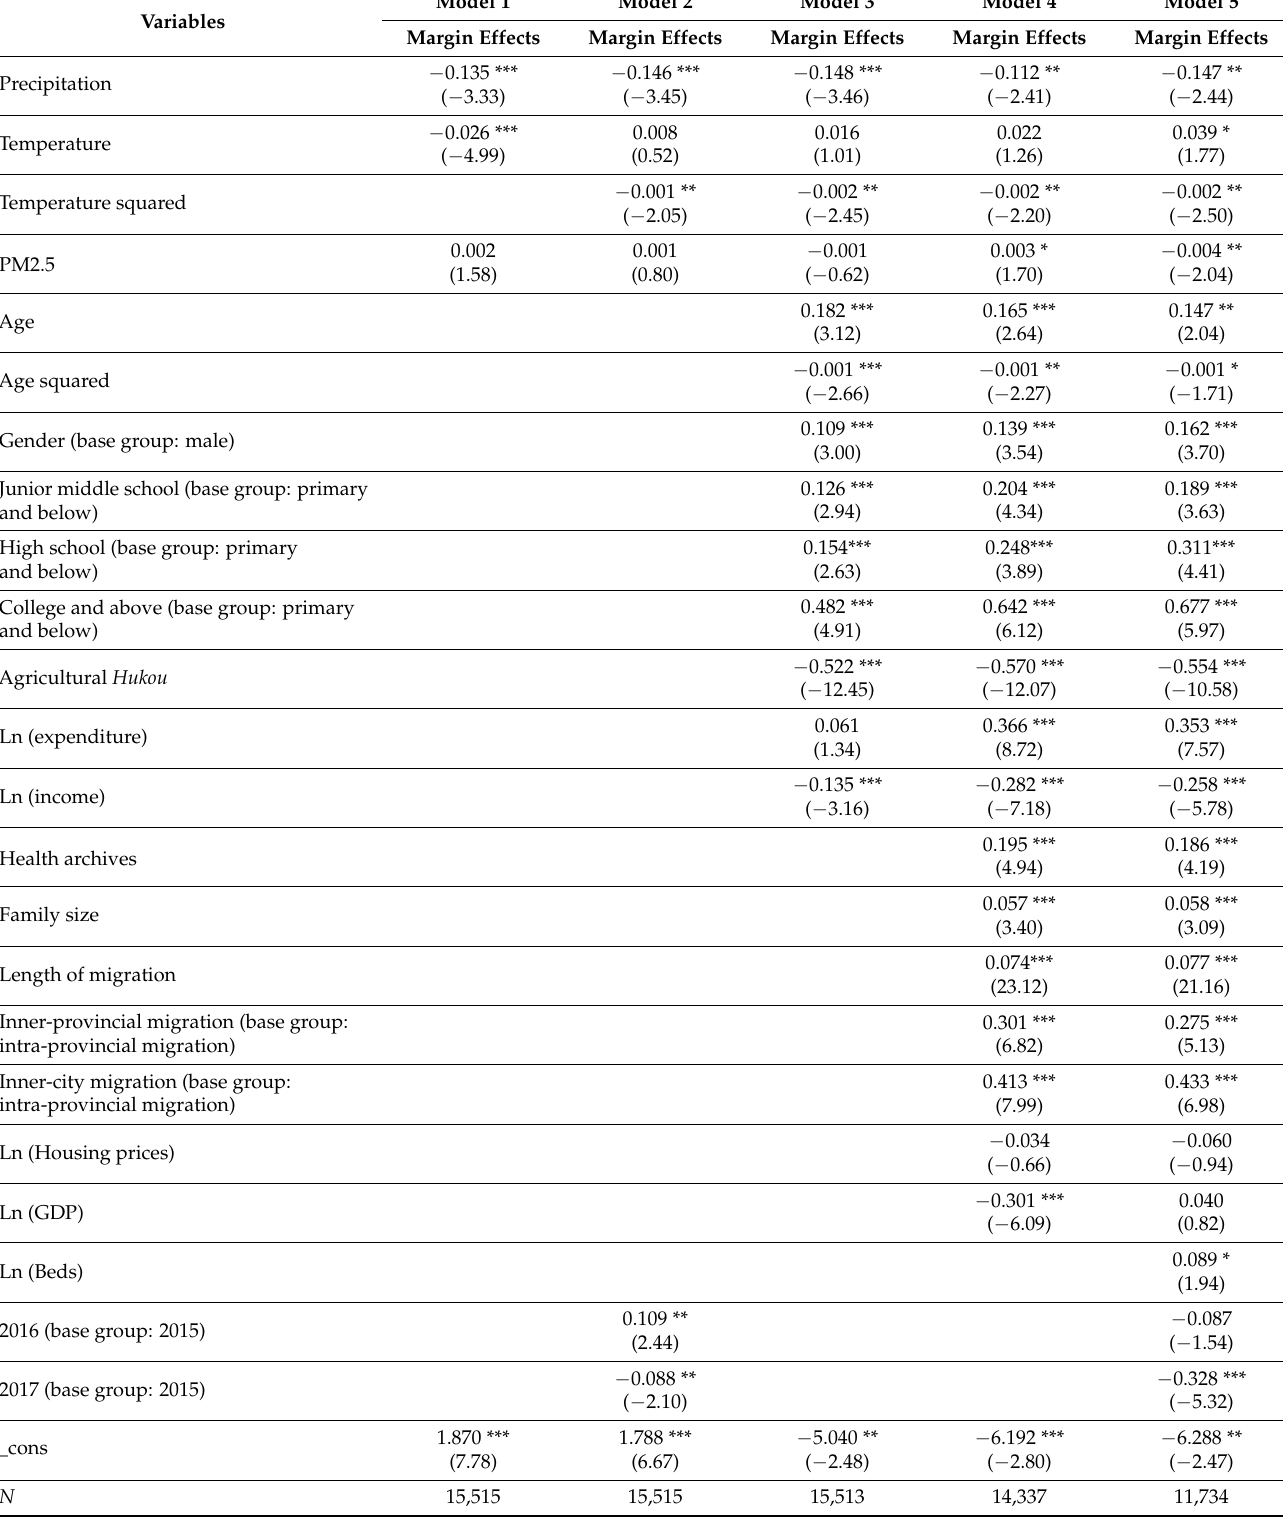
Table 3. The effect of natural amenity on elderly migrants’ urban